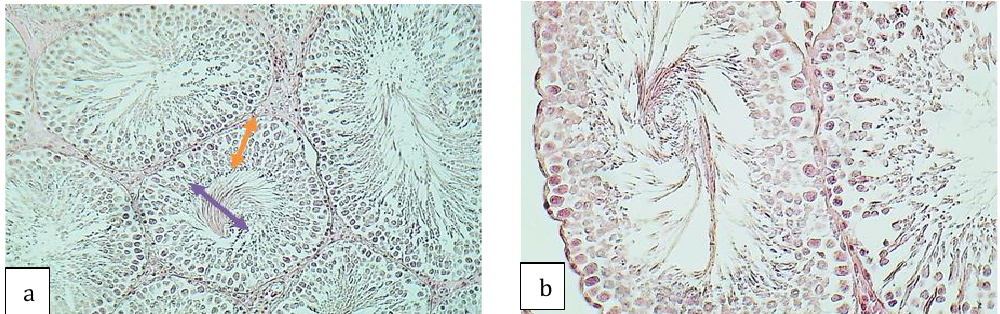
Figure 6. A photomicrograph of the right testis of an adult male Wistar rat intubated resveratrol (G3) showing a) normal architecture of germinal layers of seminiferous tubules (red arrow) filled with spermatozoa (black arrow) (H&E, 200×), b) normal appearance of seminiferous tubules with active spermatozoa (arrow) (H&E, 400×)